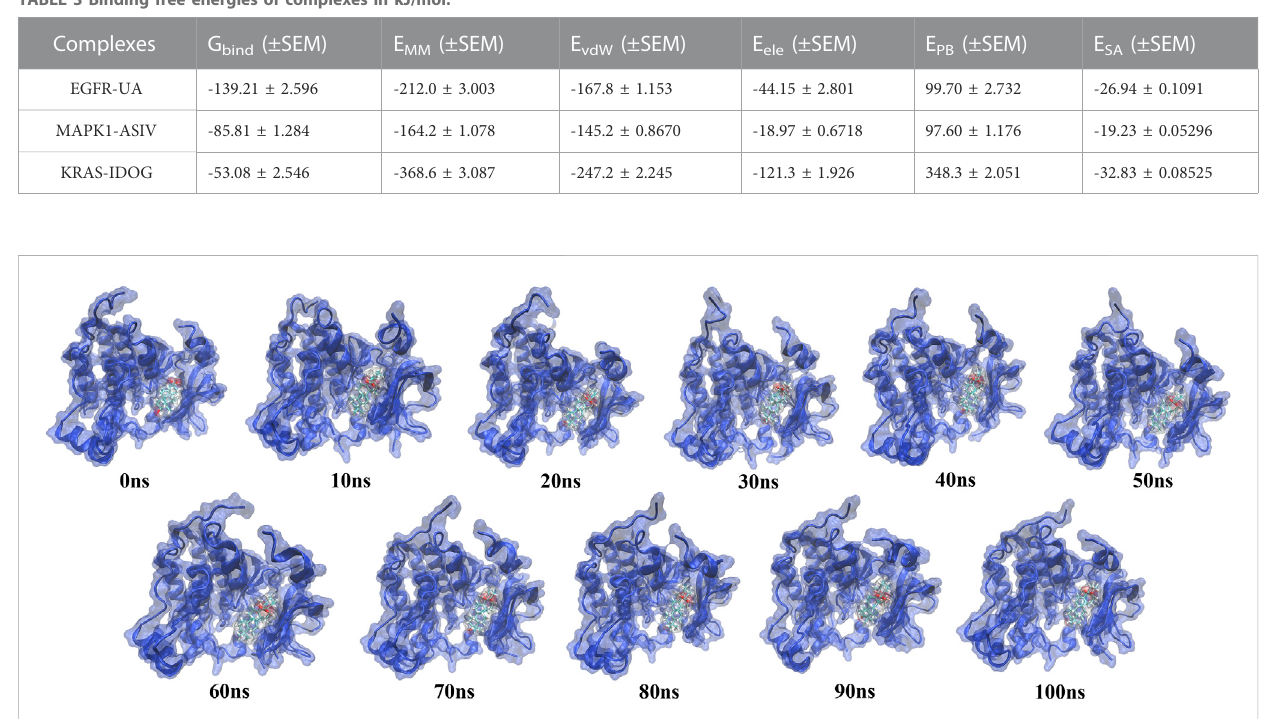
FIGURE 9 Snapshots of molecular dynamics simulations taken at 10-ns intervals that point to the movement of UA inside the binding site of EGFR.